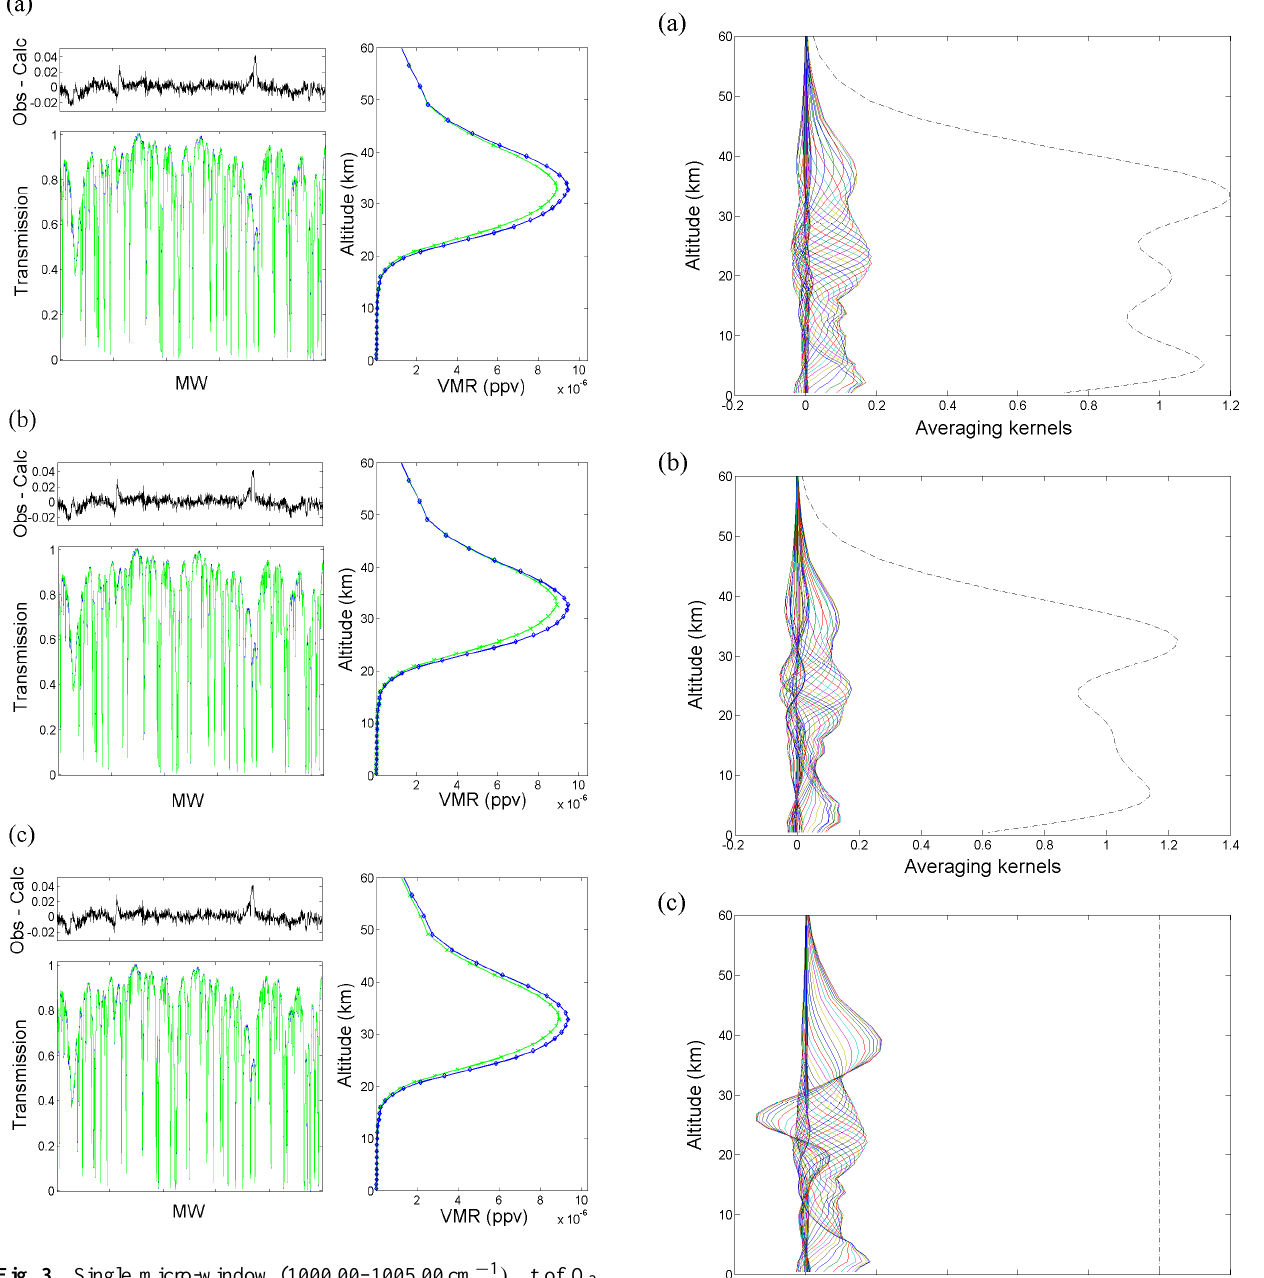
Figure 3. Single micro-window (1000.00 – 1005.00 cm -1 ) fit of O 3 plus interfering species from a single spectrum on September 12, 2007 at St.-Denis using the (a) OEM, (b) IOA and (c) TR. Measured (blue) and simulated (green) spectra are shown (left lower plot), together with the residuals (left upper plot), computed as measured minus simulated. The right plot shows the a priori (green crosses) and retrieved (blue diamonds) profile.